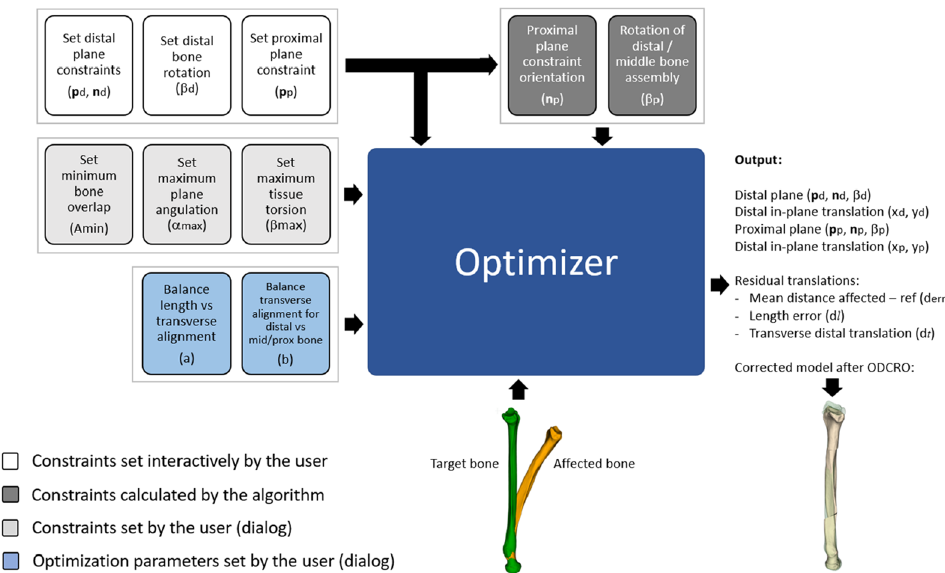
Figure 4. Diagram showing inputs to the optimizer including bone models and parameters set by the user either interactively or through a dialog window. Some input parameters are calculated automatically by the algorithm. The optimizer provides the osteotomy parameters (distal and proximal plane position and orientation; in-plane translations and bone rotations) residual translations, and the corrected bone